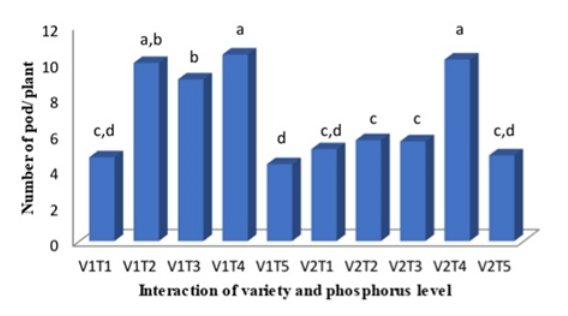
Figure 2 Interactive effect of varieties and different levels of phosphorus on the number of pods per plant in mungbean.